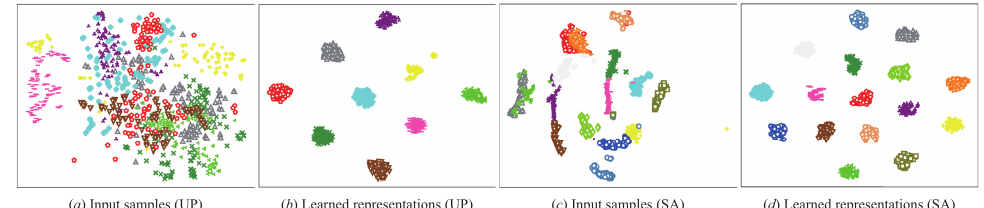
Figure 11. Visual presentation of the input samples and learned representations. Different colors represent different